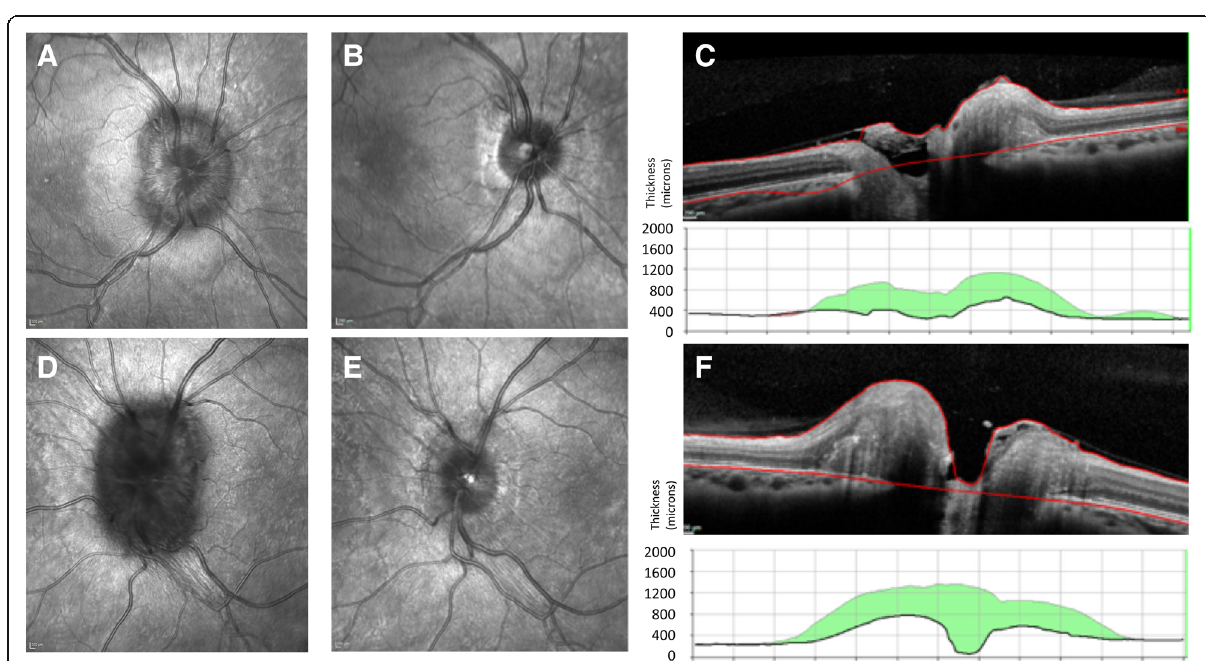
Fig. 4 Optical coherence tomography highlighting improvement of papilloedema. OCT is useful for monitoring of changes in papilloedema. a , Right eye infrared (IR) image of a swollen optic nerve. Note the Paton ’ s lines (circumferential lines) between 9 o ’ clock and 11 o ’ clock. b , Right eye IR image the nerve following a low calorie diet 6 weeks later. Note the tidemark changes of the extent of the previous oedema. c , Right eye cross-sectional image half way through the optic nerve head. Note the high line indicates the height of the swelling at diagnosis and the green volume reduction from the first scan to the most recent one (in this case 6 weeks). d , Left eye IR image of a swollen optic nerve. Note the difference between a and d , indicating asymmetric papilloedema with worse papilloedema in the left eye. e , Left eye IR image the nerve following a low calorie diet 6 weeks later. Note the tidemark changes of the extent of the previous oedema. f , Left eye cross-sectional image half way through the optic nerve head. Note the high line indicates the height of the swelling at diagnosis and the green volume reduction from the first scan to the most recent